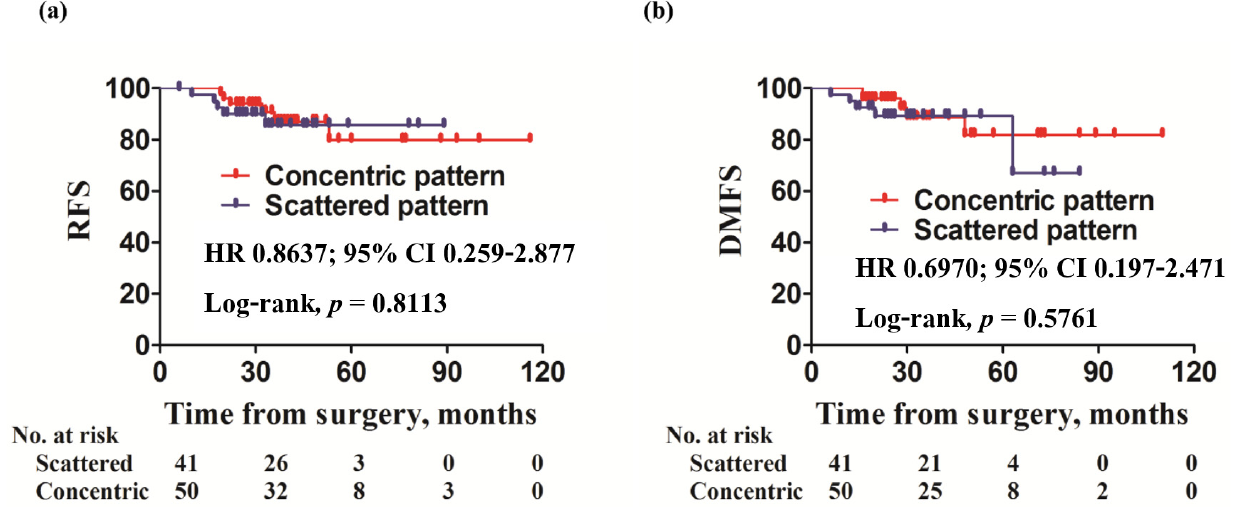
Figure 3. Kaplan–Meier survival curves of recurrence free survival (RFS) and distant metastasis-free survival (DMFS) according to tumor degradation pattern. No significant difference was found in RFS or DMFS based on the residual tumor pattern (( a ), RFS, HR 0.8637, 95% CI 0.259–2.877, p = 0.8113; ( b ), DMFS, HR 0.6970, 95% CI 0.197–2.471; p = 0.5761, log-rank test, respectively). RFS, recurrence-free survival; DMFS, distant metastasis-free